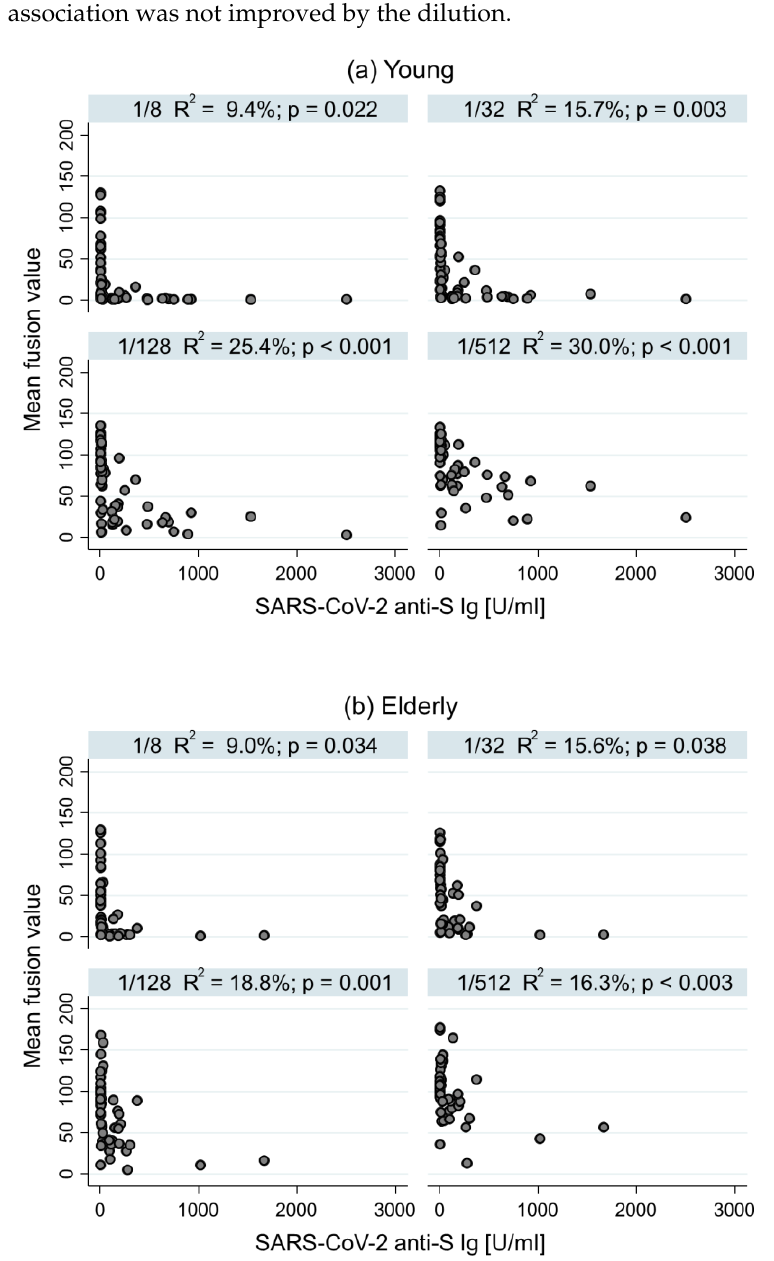
Figure 2. Association between fusion and anti-S Ig antibody level by groups and by dilution.